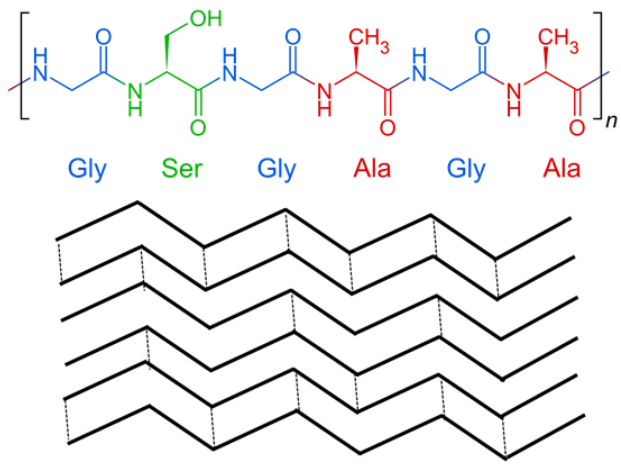
Figure 3. The primary and secondary structure of silk fibroin.